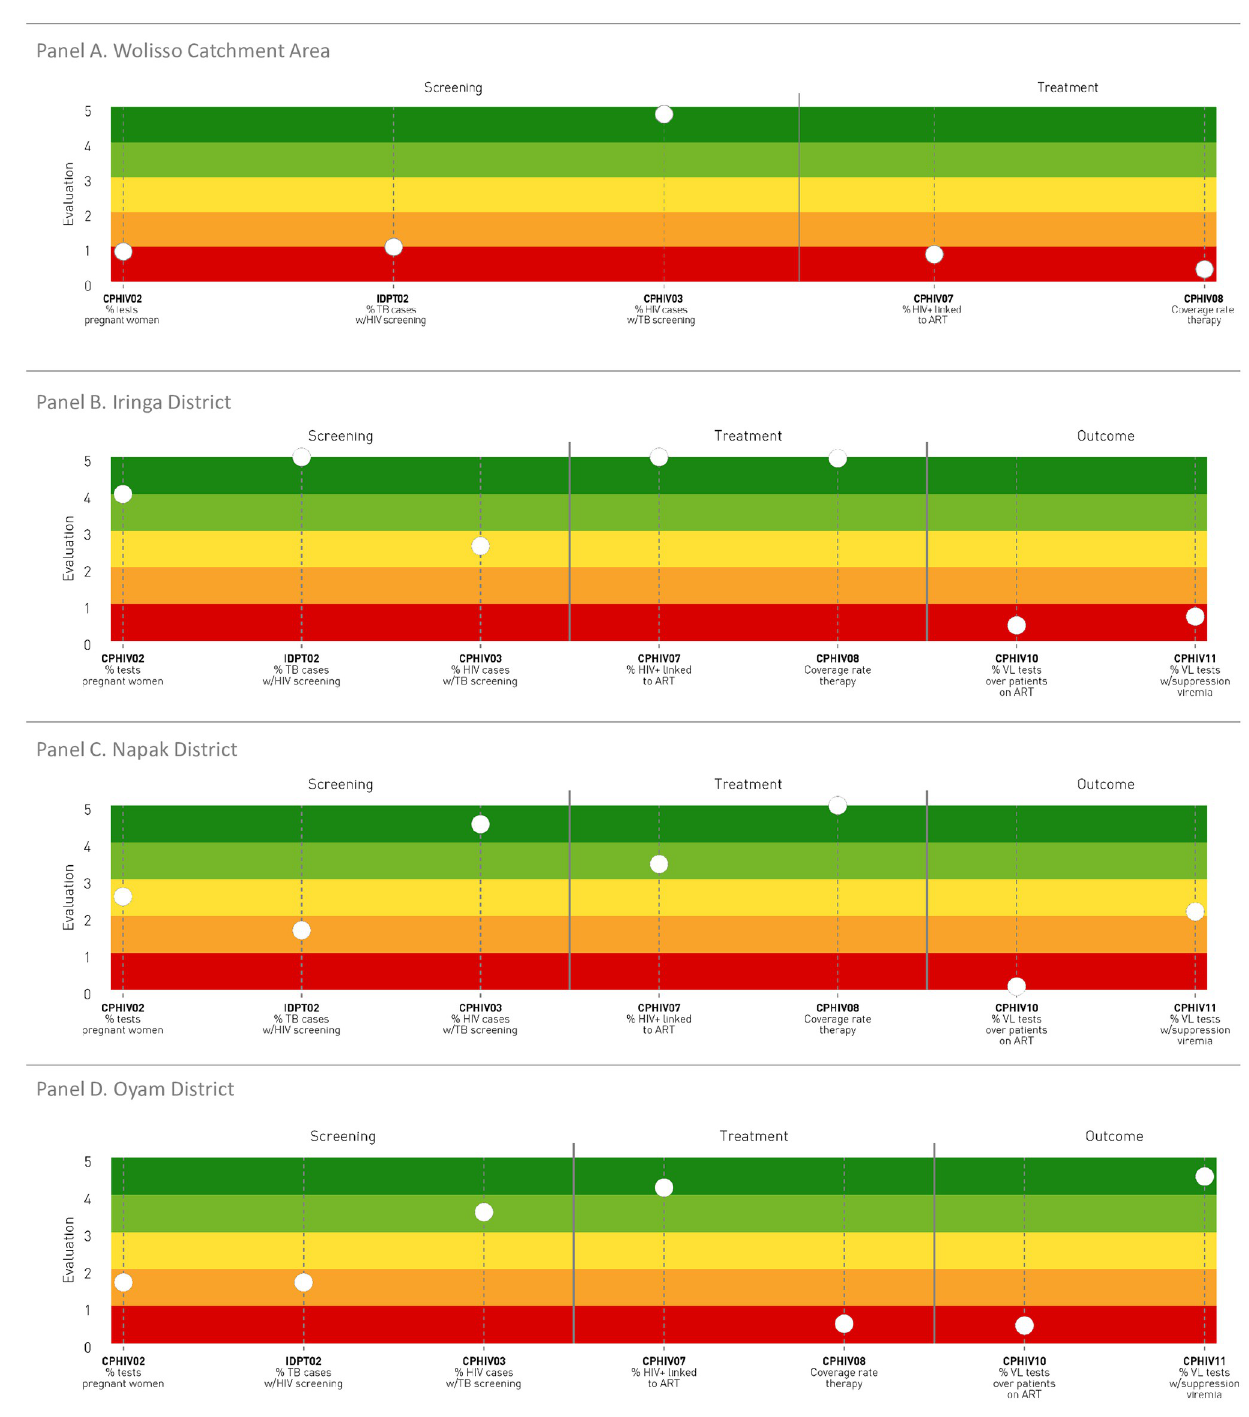
Fig 4. HIV/AIDS care pathway. Performance of care pathways related to HIV/AIDS.